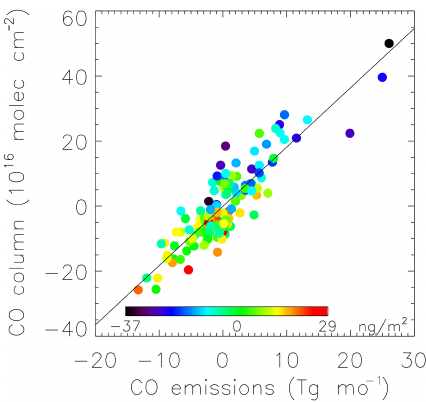
Figure 5. Monthly simulated CO column anomalies from the Ref- C1-SD simulation as a function of CO emissions for 10 ◦ S–10 ◦ N. Colors indicate the simulated OH column anomaly for the given